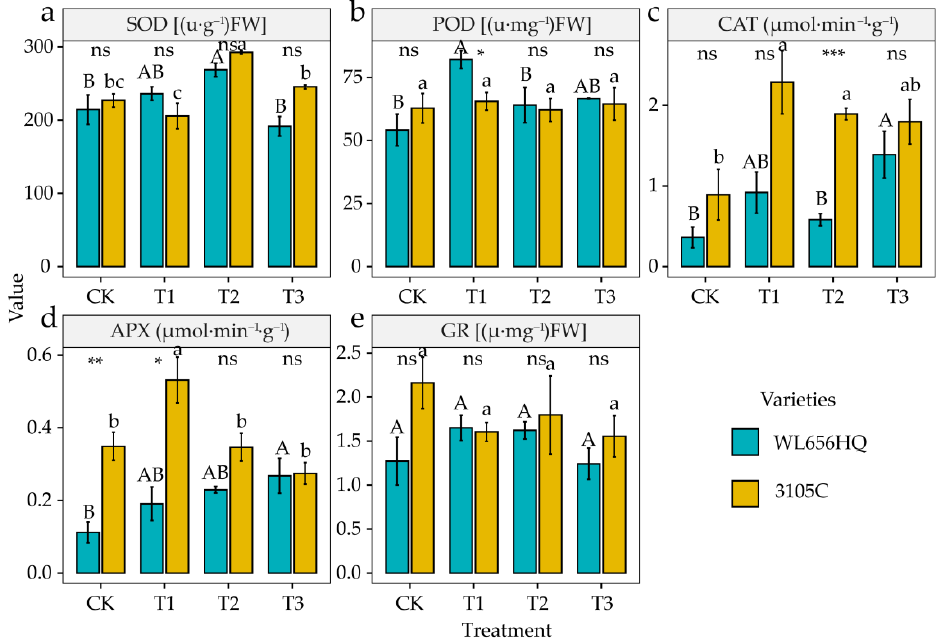
Figure 7. Effect of autotoxicity on antioxidant enzyme activities and antioxidant contents of alfalfa. The blue in the box plot represents the variety WL656HQ; the yellow represents the variety 3105C. The different lowercase and uppercase letters represent the significance of 3105C and WL656HQ at different concentrations. * Indicates the difference between the two varieties. The value p ≤ 0.05 is marked as *. The value p ≤ 0.01 is marked as **. The value p ≤ 0.001 is marked as ***. The value p > 0.05 is marked as ns. ( a ) SOD; ( b ) POD; ( c ) CAT; ( d ) APX; ( e ) GR.